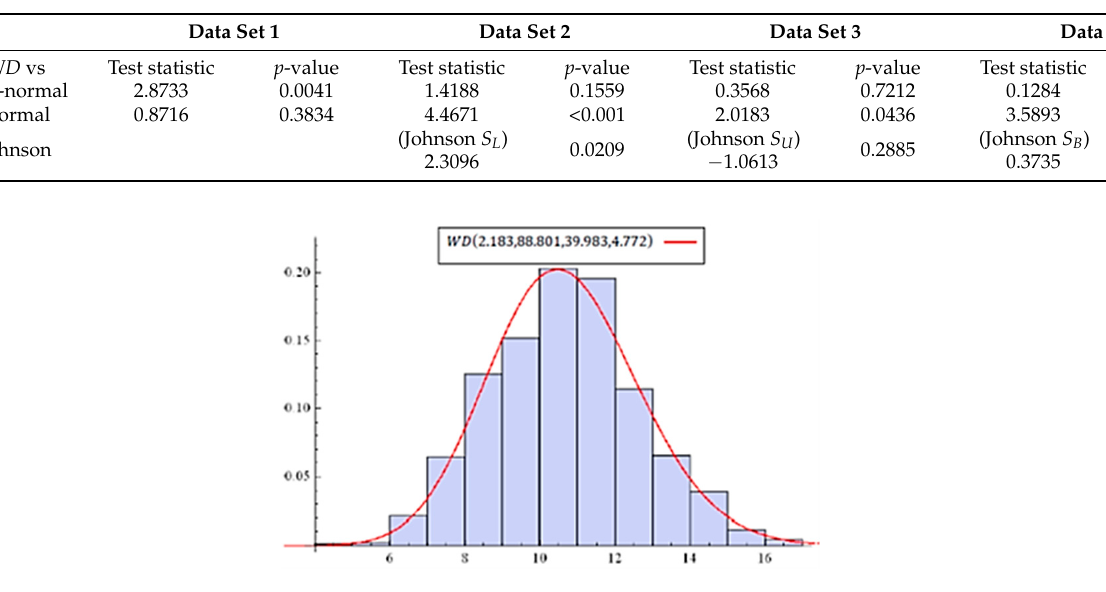
Figure 5. Estimated density of 𝑊𝐷(𝛼, 𝛽, 𝛾, 𝜆) for data set 1.